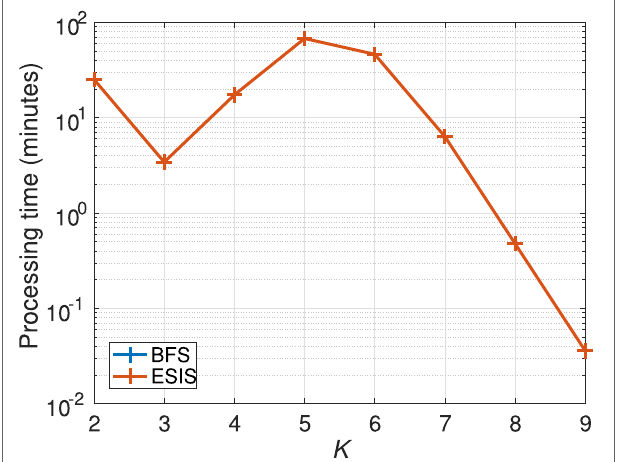
FIGURE 6 | Sums of cardinalities of ESs obtained by ESIS and numbers of derivative tuples in the ESs for Experiment